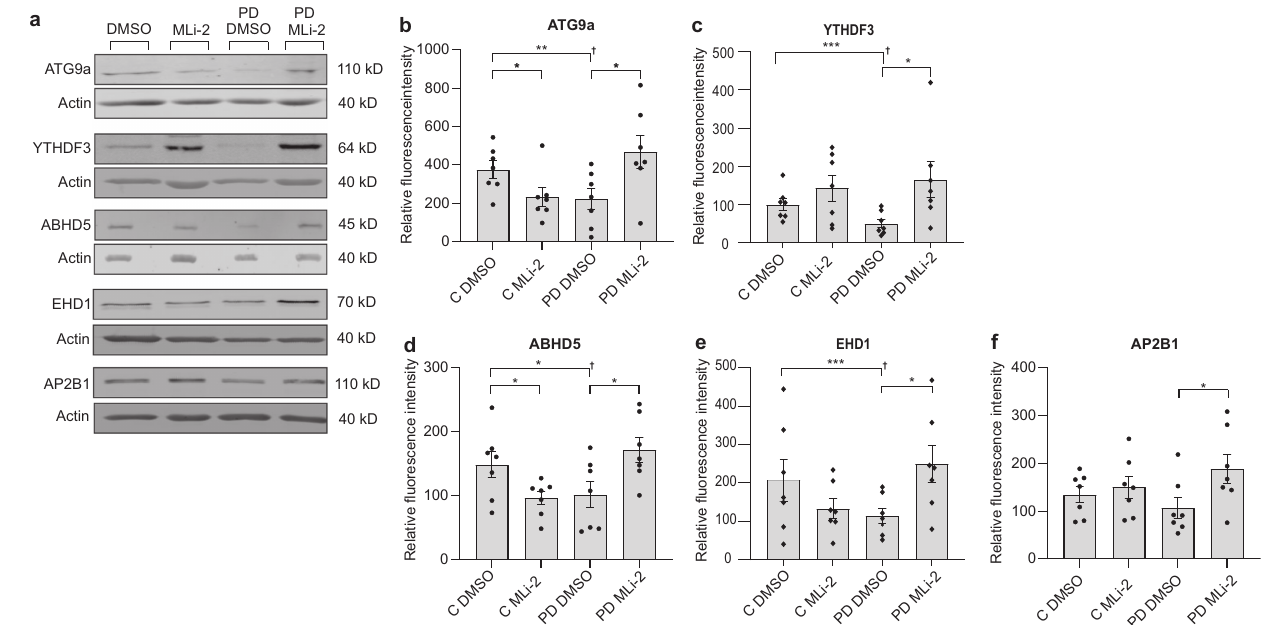
Fig. 7 Translationally repressed protein levels are recovered upon treatment with LRRK2 inhibitor. a Representative western blots of TUH healthy and sporadic PD fi broblasts treated with MLi-2 (100 nM) or DMSO for 16 h as indicated. b – f Quanti fi cation results from fl uorescence detection of proteins by immunoblotting is shown for ATG9A, YTHDF3, ABHD5, EHD1, and AP2B1 from healthy and sporadic PD patient fi broblasts. Normalized data and SEM are shown. To determine if these proteins decreased compared to baseline (calculated from the average of all healthy samples p -value † ), a one-tailed t -test was